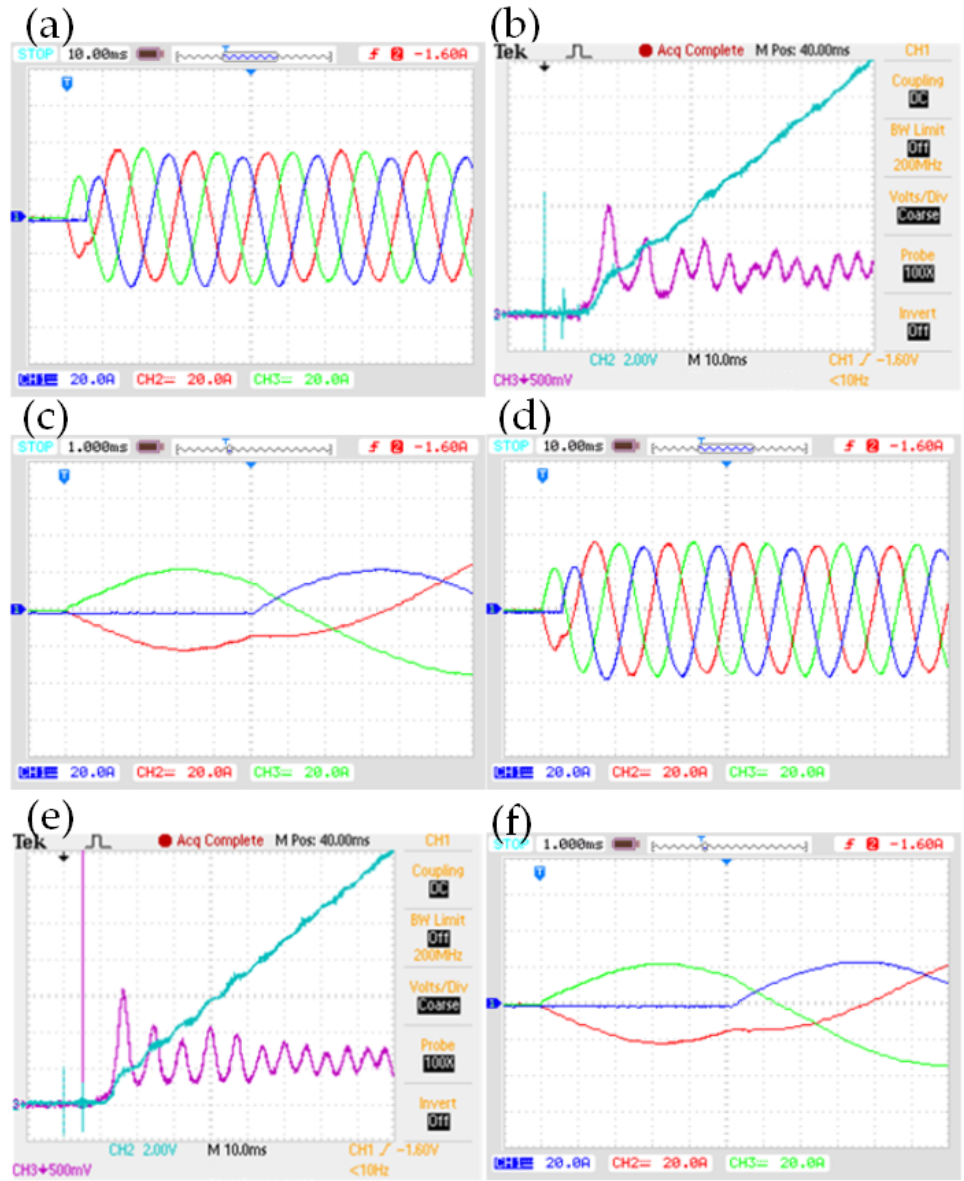
Figure 20. Waveforms of physical quantities during the direct start-up of the electromechanical system by means of a vacuum circuit breaker with a delay of switching on the phase supplying the motor by 5 ms, where: ( a , c , d , f ) concerns the stator winding currents ( i A —CH1, i B —CH2, i C —CH3: scale 20 A/div), ( b , e ) concerns the torque on the shaft ( T —CH3: scale 50 Nm/1V) and the rotor speed of the motor ( n —CH2: scale 15